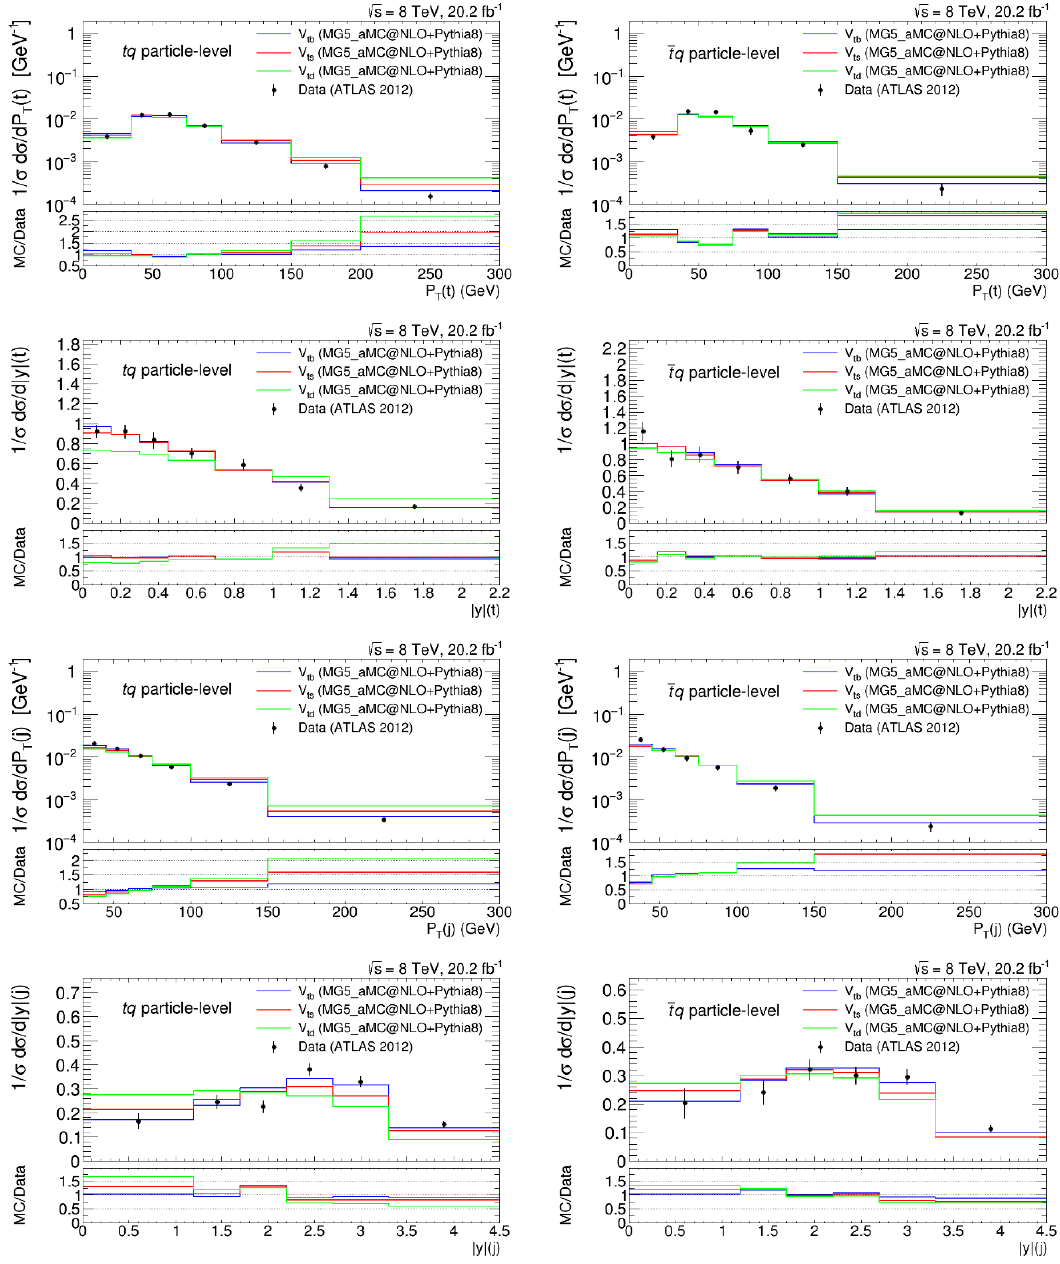
Figure 4 . Comparison of the normalized di(cid:11)erential cross sections for single top (left) and anti-top (right) production via Wtb (blue line), Wts (red line) and Wtd (green line) interactions at particle level. Observables are the same as those shown in (cid:12)gure 3. Data are taken from ref. [22] (ATLAS Collaboration, 8 TeV).